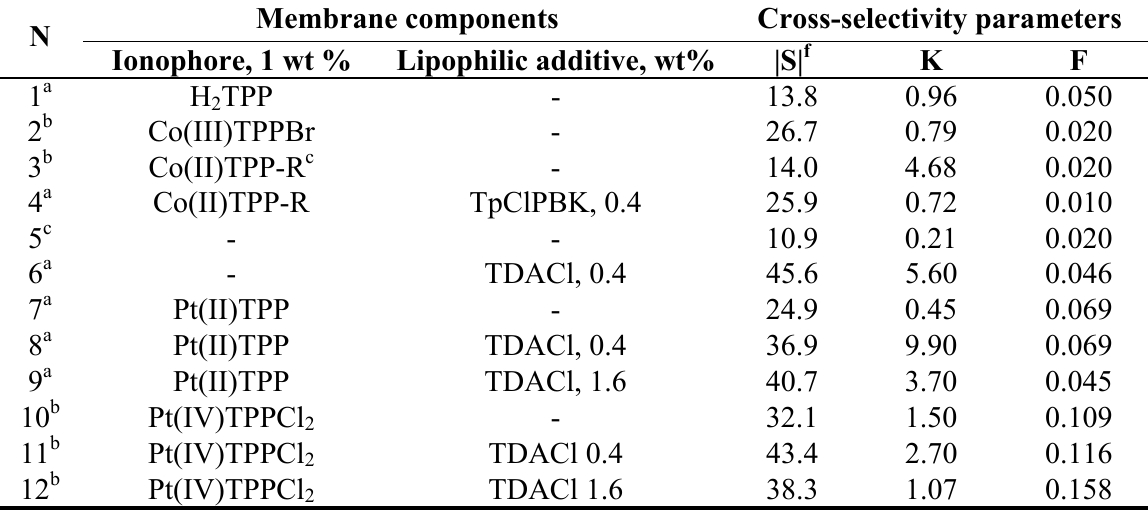
Table 1. Composition of studied membranes and their cross-sensitivity parameters; polymeric matrix composition PVC:plasticizer ( a,b,c )= 1:2 in weight; a DOS, b oNPOE , c TOP, d R: -O-(CH f Absolute value of the average slope of cationic or anionic sensor